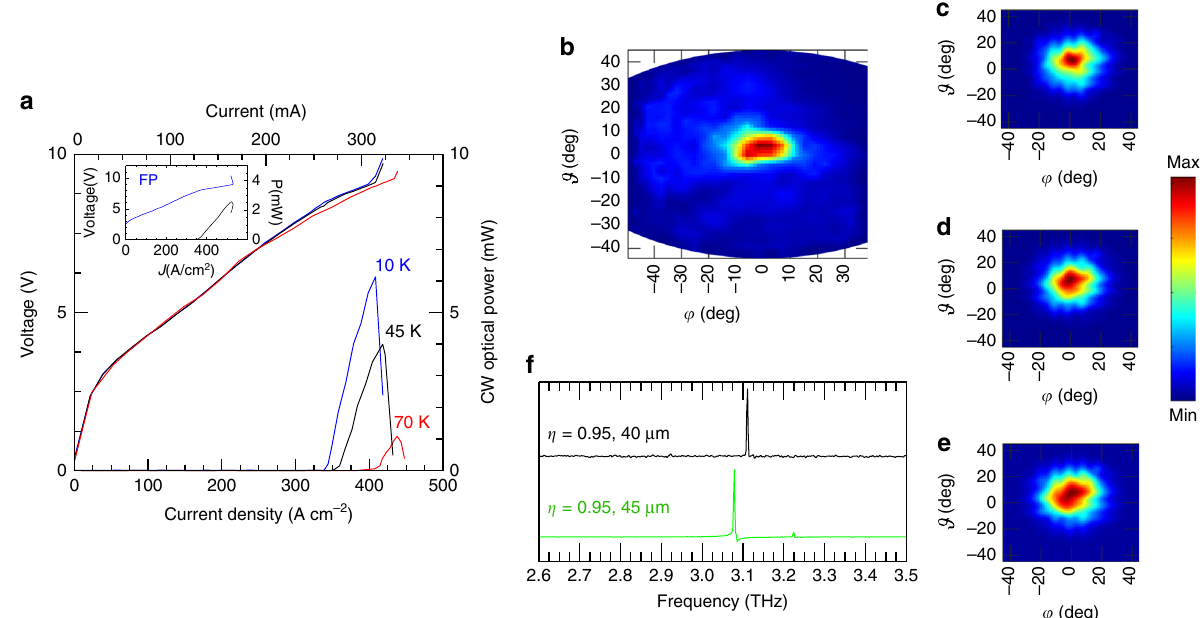
Fig. 5 Continuous-wave operation. a Voltage – current density ( V – J ) and power – current density ( L – J ) characteristics measured in continuous-wave mode and at different heat-sink temperatures, for a representative wire laser having η = 0.95 and an average sinusoidal cavity width of 45 µ m. Optical power scales were corrected to account for the detector collection ef fi ciency and the absorption of the polyethylene cryostat window. Inset: V – J and L – J characteristics measured in continuous-wave mode and at 10 K, for a representative Fabry – Perot (FP) edge-emitting wire laser fabricated from the same semicondictor heterostructure wafer and having a width of 45 µ m and a cavity length of 1.1 mm. b Far- fi eld intensity pattern of the device in a , measured at a distance of 8 cm from the laser surface. c – e Simulation of the far- fi eld emission intensity pro fi le of the emitting optical mode, derived by applying the Stratton-Chu method to the near- fi eld emission of the fundamental mode, for a hole radius r = 5 µ m, r = 10 µ m, and r = 12 µ m. f FTIR emission spectra collected in rapid scan mode at a 0.125 cm − 1 resolution and with an internal deuterated triglycine sulfate (DTGS) pyroelectric detector for a set of devices having the same η = 0.95 and different average